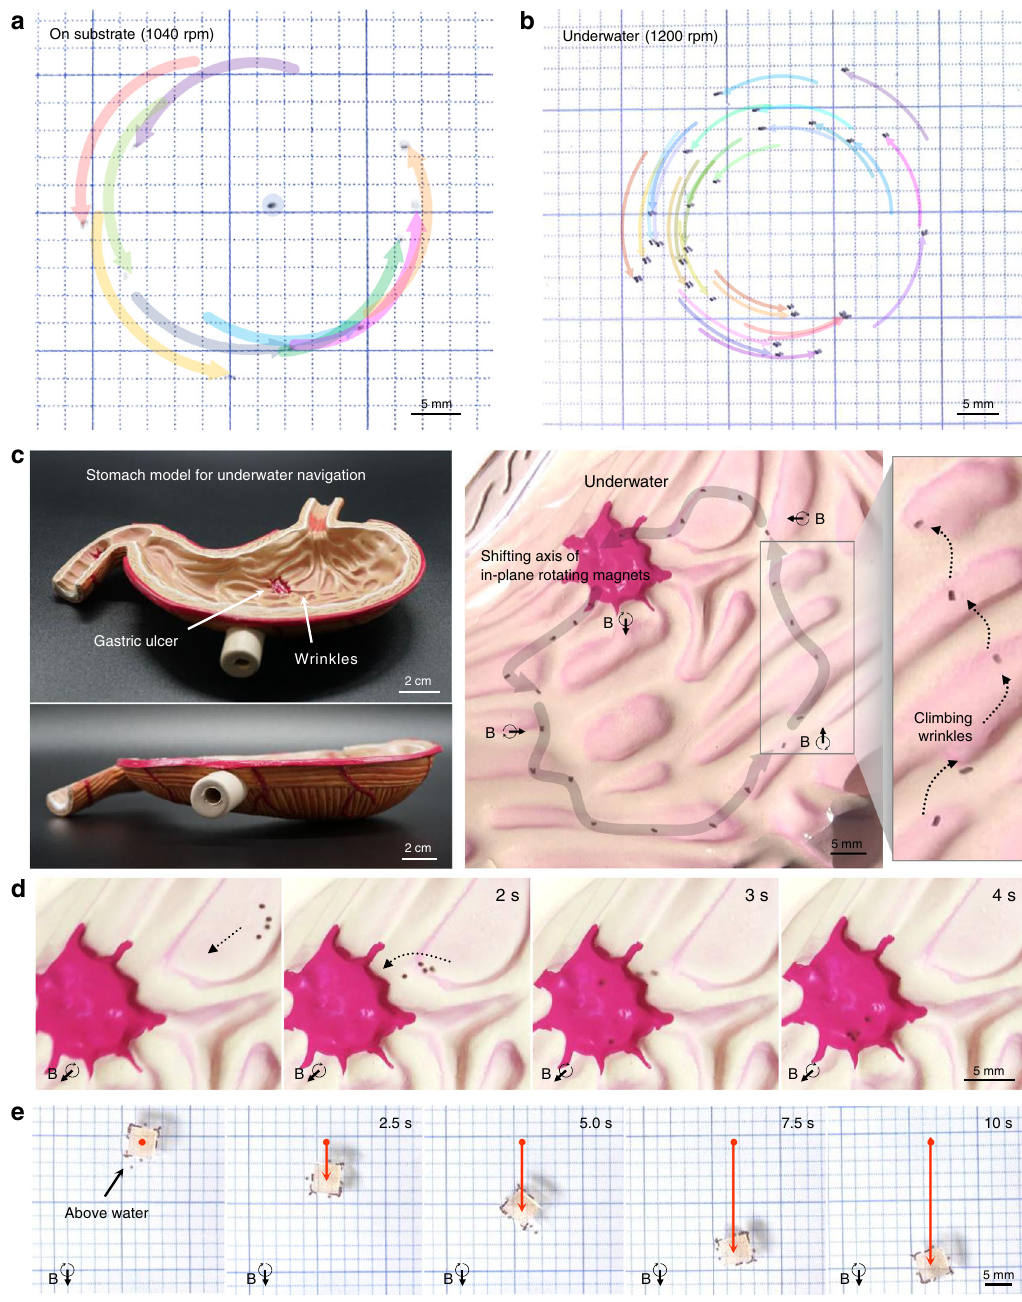
Fig. 5 Multiple soft robots exhibiting collective behavior. a Ten spinbots actuated on the ground. b Underwater swimming of 37 spinbots actuated on the ground. c Underwater navigation of the single spinbot to a target gastric ulcer in the anatomical model of the stomach, for 20 s (1040 r.p.m.) and d multiple soft robots (1580 r.p.m.) through shifting axis of in-plane rotating magnets. e Transportation of cargo through collective motion of the spinbots above water as the axis of rotating magnets moves downward at a velocity of 2.3 cm s − 1 (1040